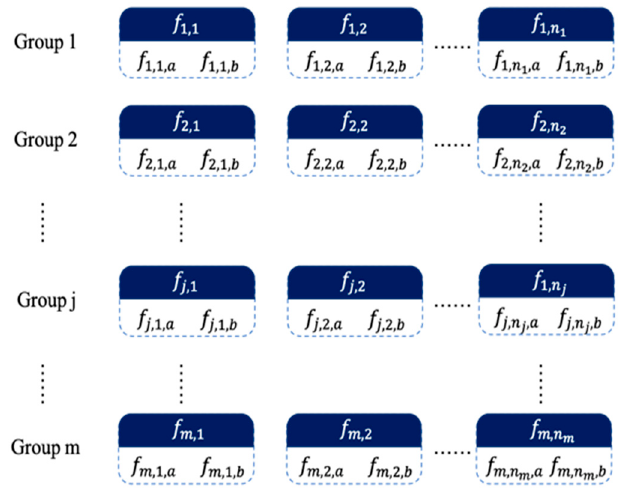
Figure 3. HR peak pair cells screened out from each group of spectrums. The color block above each cell is the average of cell frequencies, and the bottom is the frequency contained in the cell. The array composed of the mean values of each group cells is denoted as H cand , and the array composed of the peak values contained in each group cells is denoted as H candf